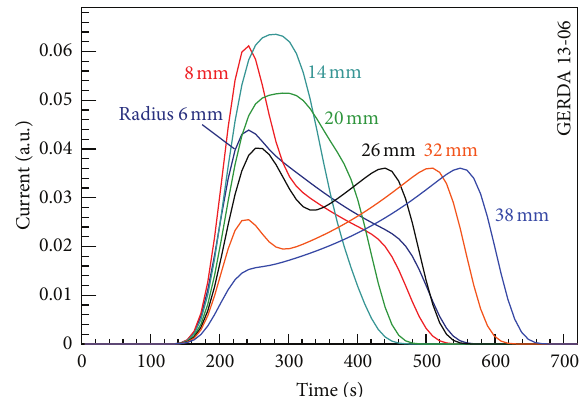
Figure 12: Simulated current pulse shapes for SSE in a semicoaxial detector taken at various places inside the diode. The places vary from the outer n + surface towards the bore hole (n + surface) along a radial line at the midplane of the detector. From